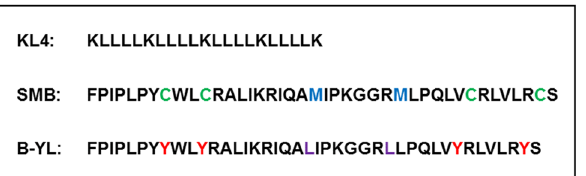
Figure 1. Amino acid composition of surfactant protein B (SP-B) peptide mimics KL4, Super Mini-B (SMB) and B-YL.